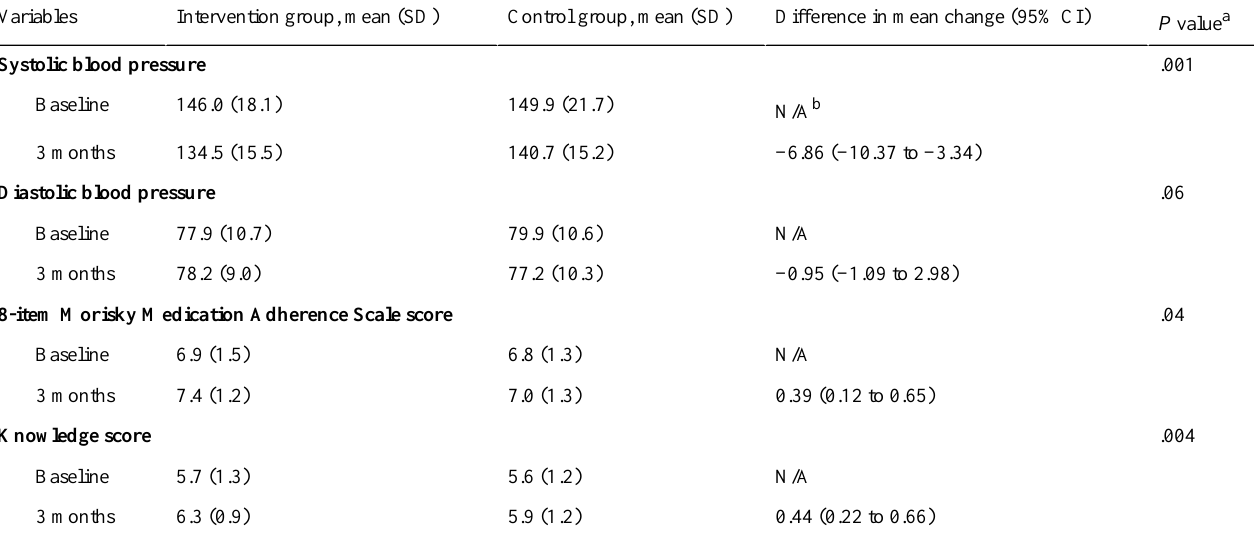
Table 5. Baseline and changes in systolic blood pressure, diastolic blood pressure, 8-item Morisky Medication Adherence Scale score, and knowledge score at each assessment point using the missing data method.